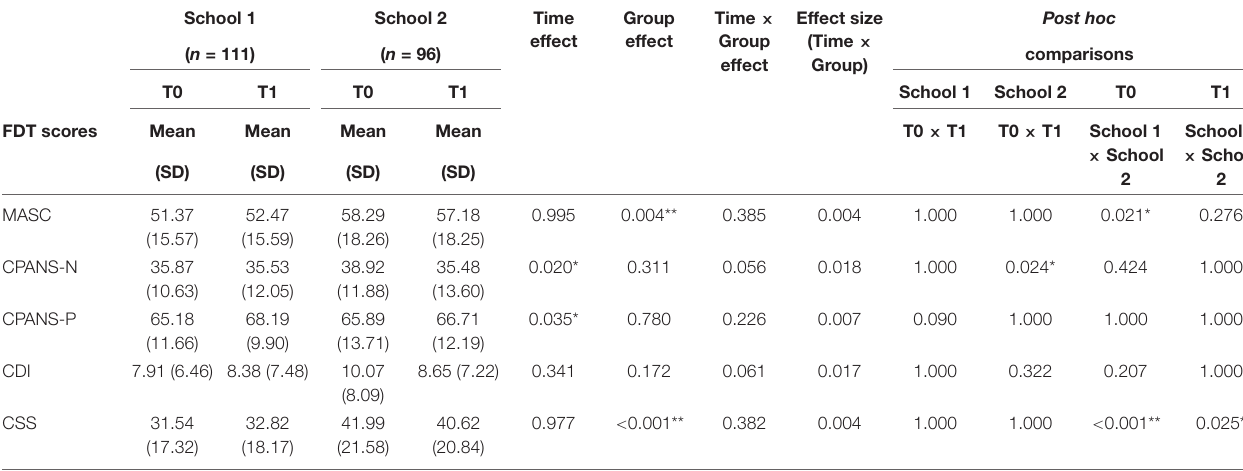
TABLE 2 | Comparisons between school 1 and school 2 for MASC, CPANS, CDI, and CSS scores in T0 (baseline) and after 8 weeks